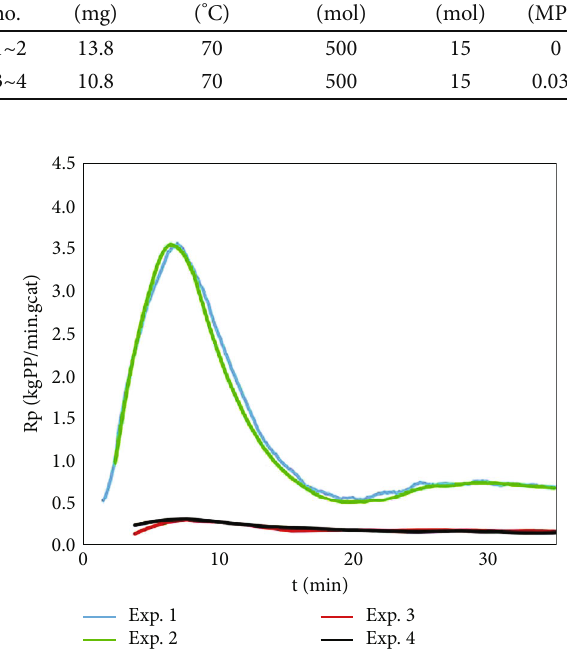
Figure 4: Propylene bulk polymerization